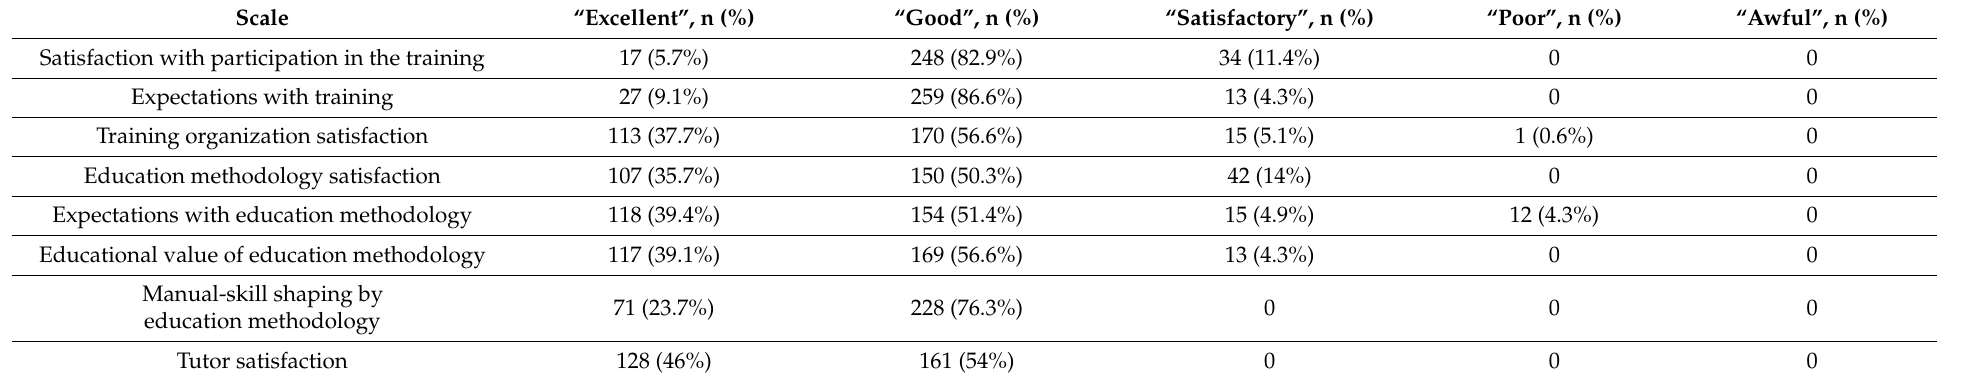
Table 2. Analysis of the distribution of comparison group participants’ opinions on training (n =